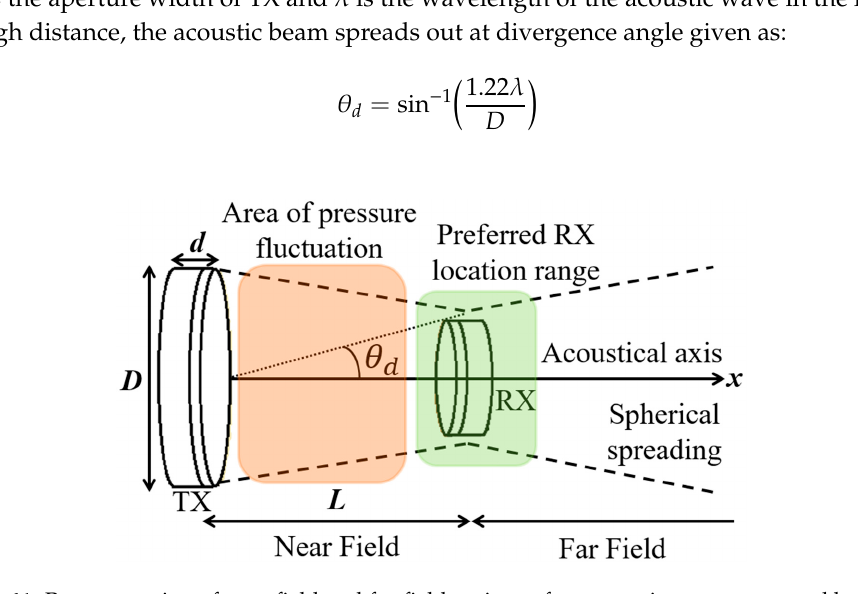
Figure 41. Representation of near-field and far-field regions of an acoustic wave generated by TX and incident on RX.